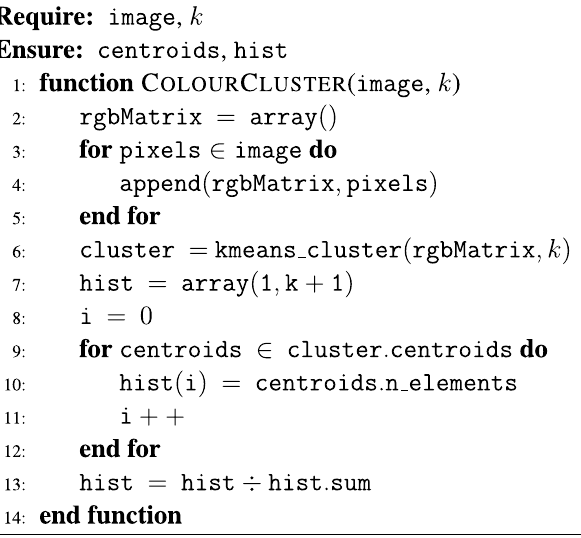
Algorithm 1. Colour clustering algorithm